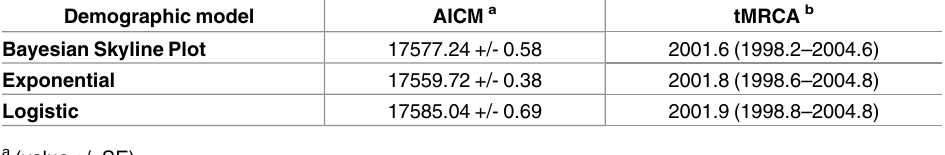
Table 2. Akaike’sInformation Criterion (AICM) values and tMRCA of the CV cluster for three demo- graphic